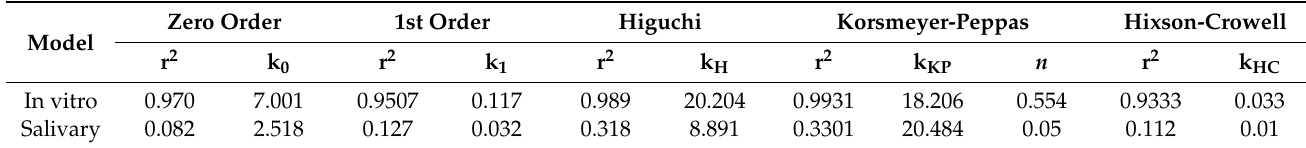
Table 4. In vitro and salivary drug release kinetics of Q7 formulation.